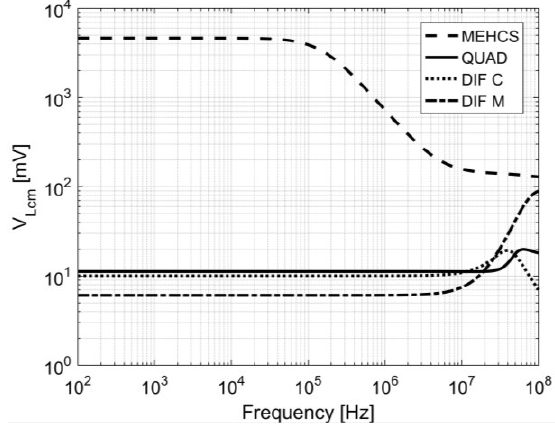
Fig.19: Simulated AC common mode load voltage ( V Lcm ) of the mirrored group and proposed group, with unmatched control resistors ( r and r x